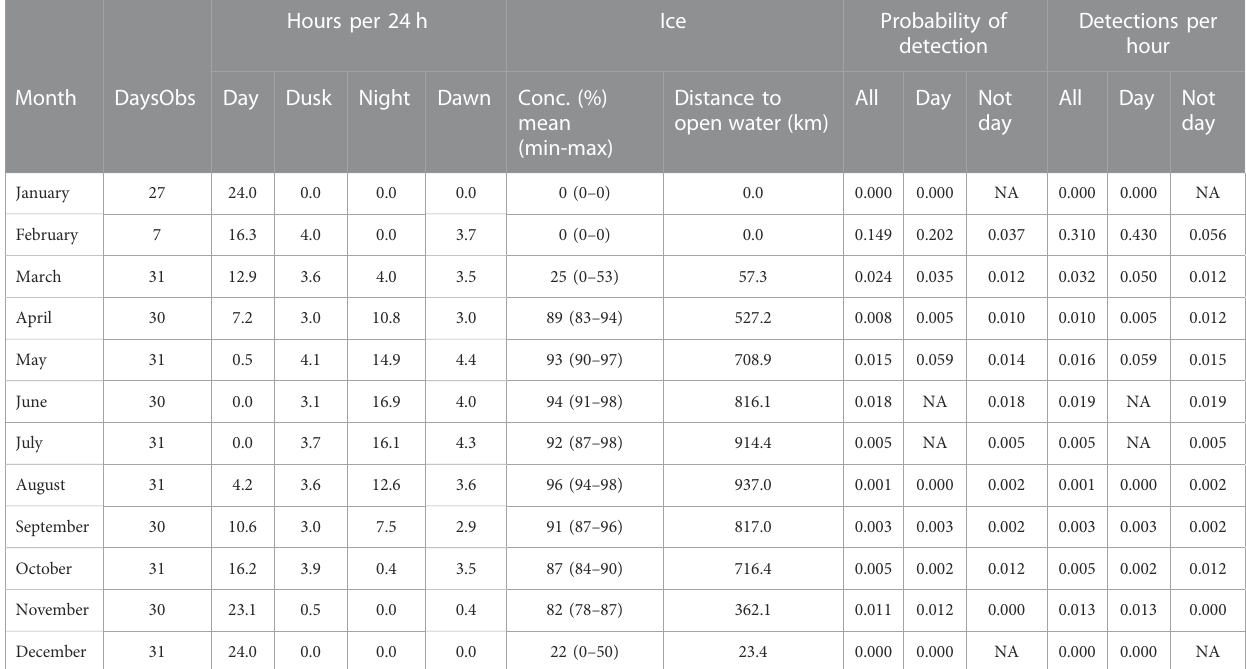
TABLE3A1summaryinformationbymonth. “ DaysObs ” :Numberofdaysinthemonthduringwhichacousticdataweremeasured. “ Hoursper24 h ” :Meannumber ofhoursofday,dusk,nightanddawn(seetextforde fi nitions).Ice:Concentration( “ conc ” )ofsea-iceinthemonthasmean%(mean±sd).Probabilityofdetection: mean probability of detecting sperm whale in an hour in a given month. “ Not day ” : Dusk, night, dawn combined. Detections per hour: Mean number of sperm whale click-trains detected in an hour in that month. “ NA ” : No